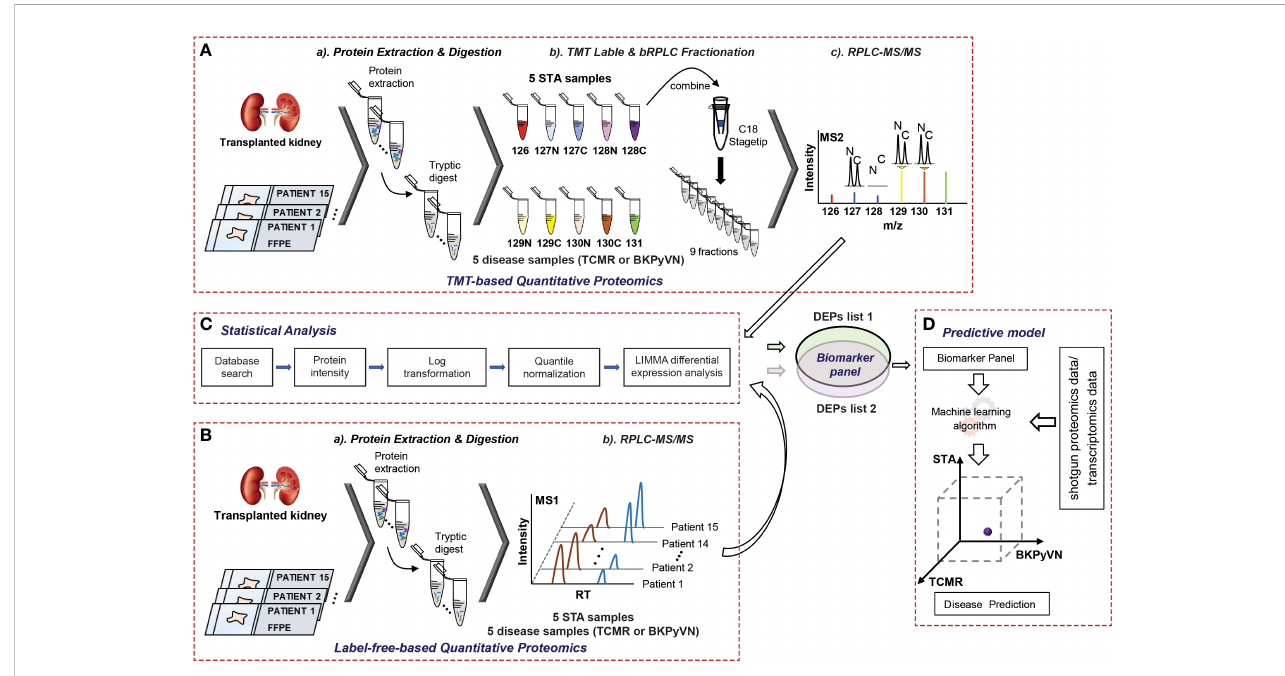
FIGURE 1 A fl ow chart showing the procedures to diagnose TCMR by FFPE biopsy-based proteomics and machine learning. (A) Experimental procedures for TMT- based quantitative proteomics. The proteins were extracted from 5 TCMR, 5 BKPyVN, and 5 STA biopsies, the digested peptides were labeled with TMT10-plex-reagents and separated by basic reverse phase C18 material. The fractionated peptides were subjected to LC-MS/MS analysis; (B) Experimental procedures for label-free quantitative proteomics. The proteins were extracted from 5 TCMR, 5 BKPyVN, and 5 STA biopsies, the digested peptides were directly subjected to LC-MS/MS analysis; (C) The proteins were subjected to a systematic statistical analysis consisting of log transformation, quantile normalization, and LIMMA analysis to obtain differentially expressed proteins; and (D) The machine learning algorithm was established based on the training data and validated with testing